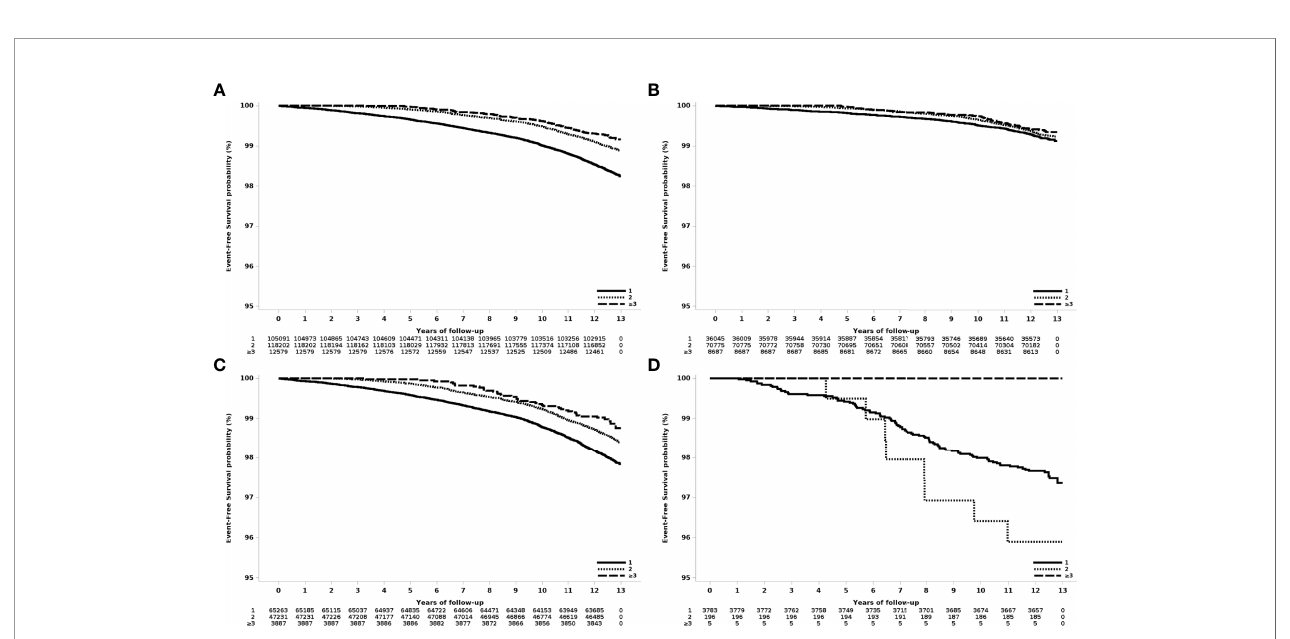
FIGURE 2 | Event-free survival according to the number of deliveries in women who had their fi rst delivery in 2007. (A) All patients, (B) age at fi rst delivery: 20-29 years old, (C) age at fi rst delivery 30-39 years old, and (D) age at fi rst delivery 40-49 years